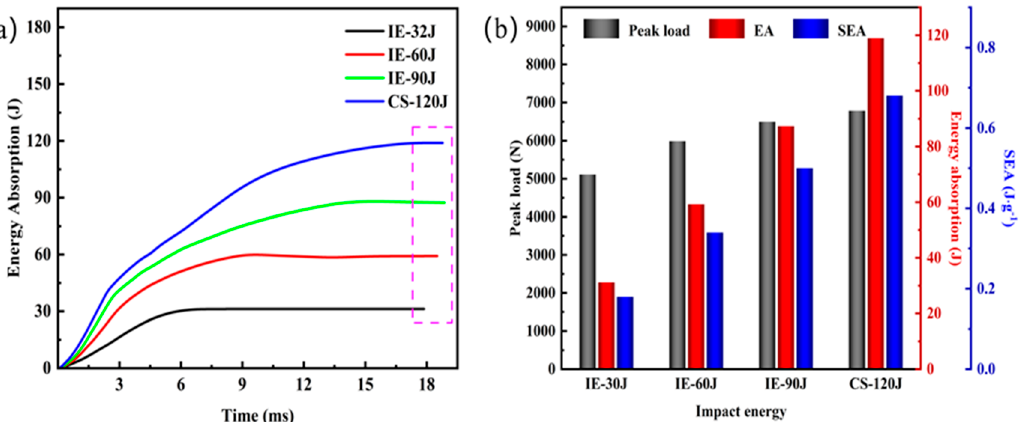
Figure 8. Evaluation of energy absorption performance at different impact energy: ( a ) Energy-time curves; ( b ) Comparison of energy absorption index of the structure.